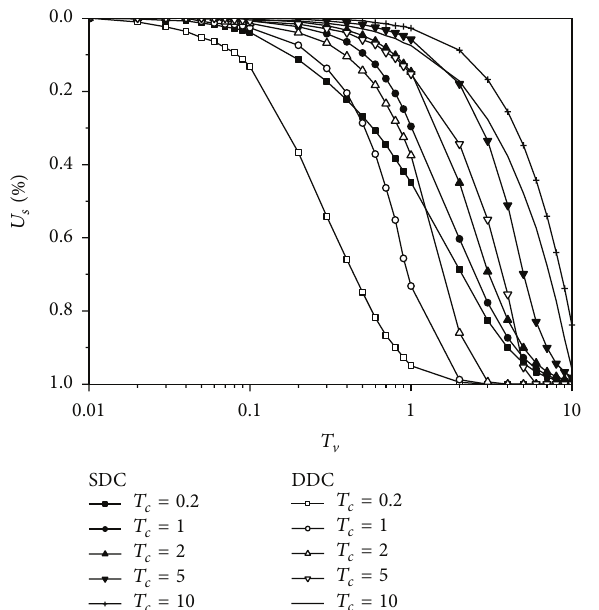
Figure 3: Consolidation curves with a uniform vertical additional stress.